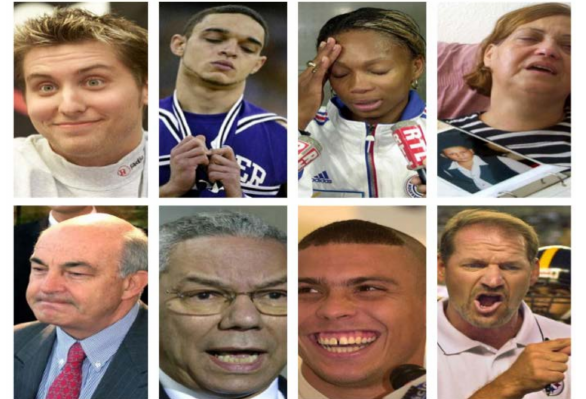
Figure 7. FDDB dataset.